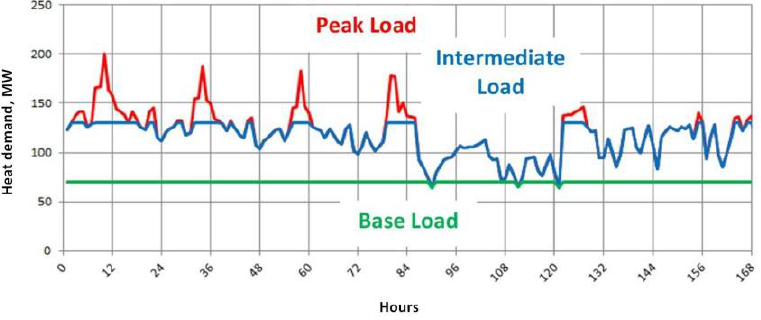
Fig. 3. Sequestration of Heat Loads occurring within the DH system modelled into peak, intermediate and base load